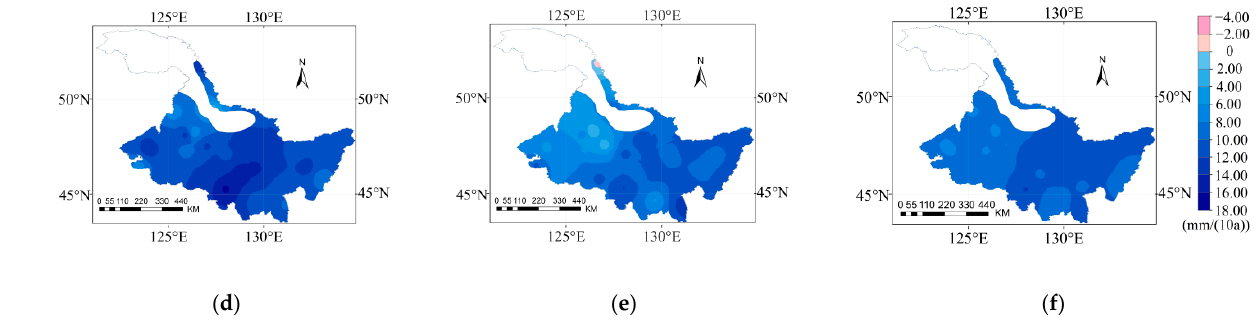
Figure 5. Climate tendency rates of ET 0 in the periods ( a ) 2021–2050, ( b ) 2051–2080, and ( c ) 2021–2080 under RCP4.5, and in the periods ( d ) 2021–2050, ( e ) 2051–2080, and ( f ) 2021–2080 under RCP8.5 during the soybean growth period.